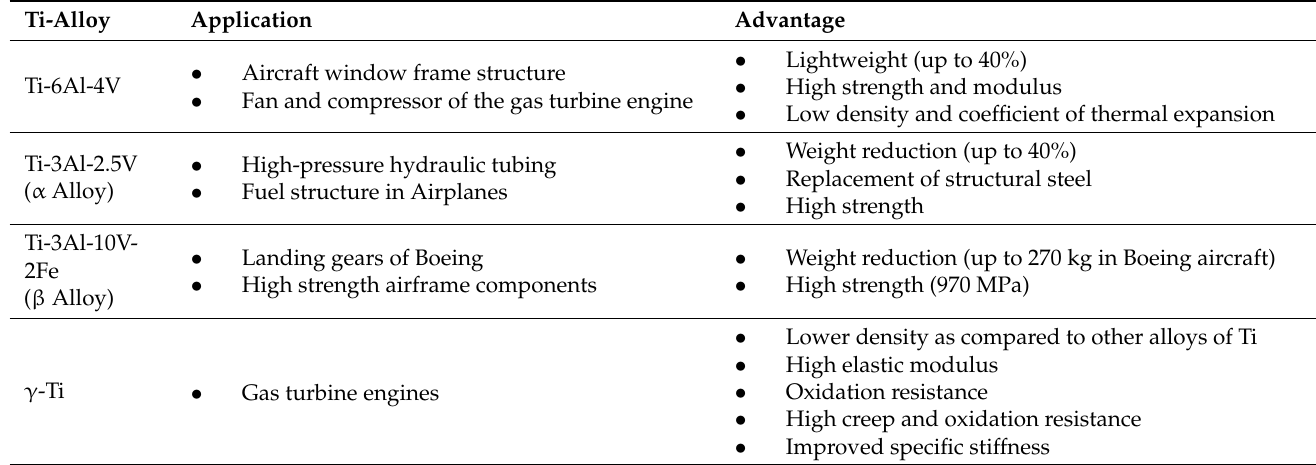
Table 1. Various types of Ti-alloys for